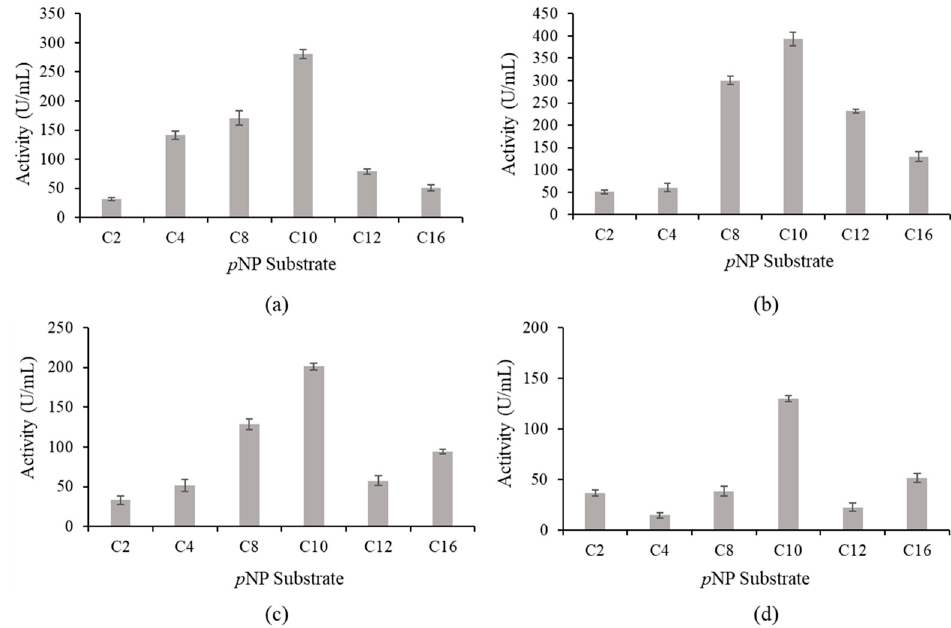
Figure 7. Substrate specificity of wt-L2 and mutant lipases was measured with p NP carbon acyl length between 2 to 16. ( a ) wt-L2, ( b ) A8V, ( c ) A8P and ( d ) A8E.